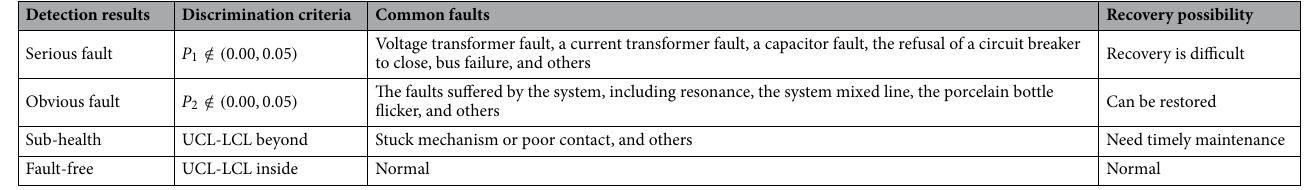
Table 4. The definitions of the detection